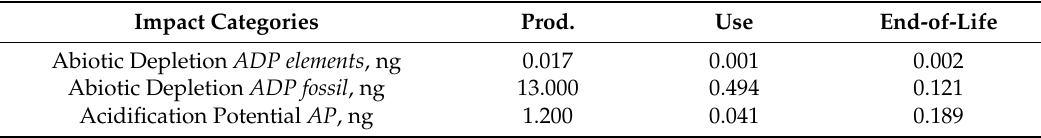
Table 4. Results of total life cycle of the product in the di ff erent life cycle stages (with looping). (Functional unit: 1 kg of polypropylene product. Normalization: CML 2016, EU 25 + 3, year 2000, excl. biogenic carbon. Weighting method: thinkstep LCIA Survey 2012, Europe, CML 2016, excl. biogenic